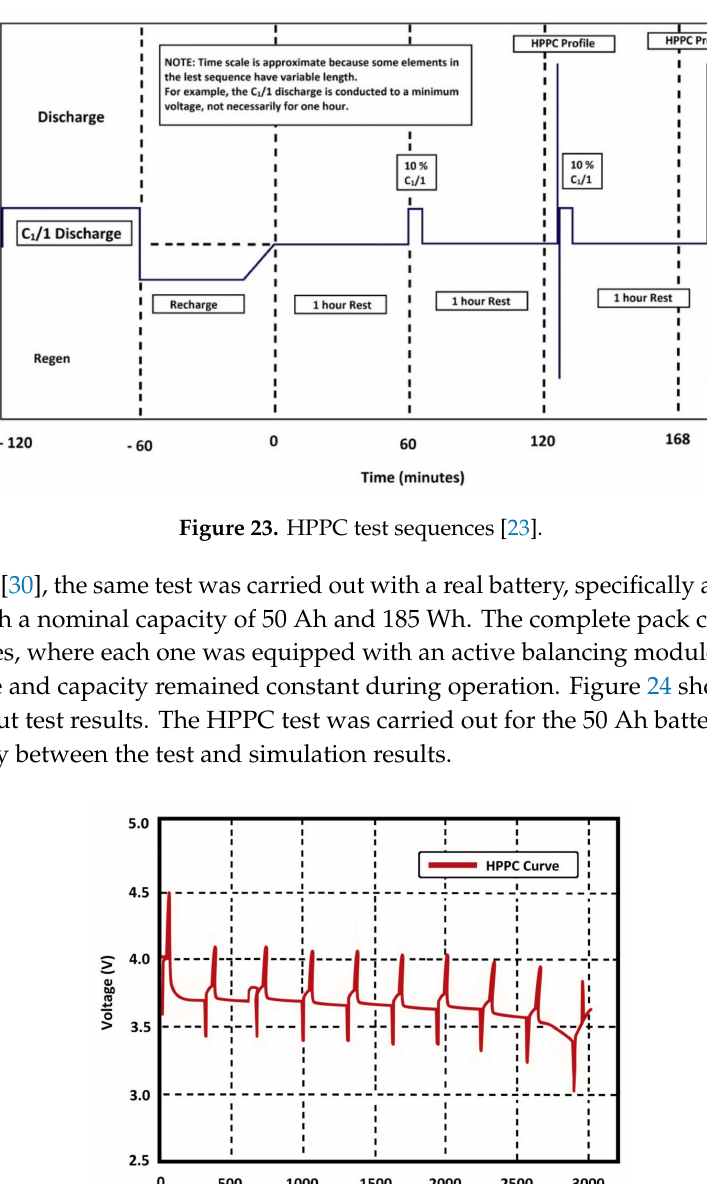
Figure 22. Output voltage of the battery when subjected to the HPPC test.